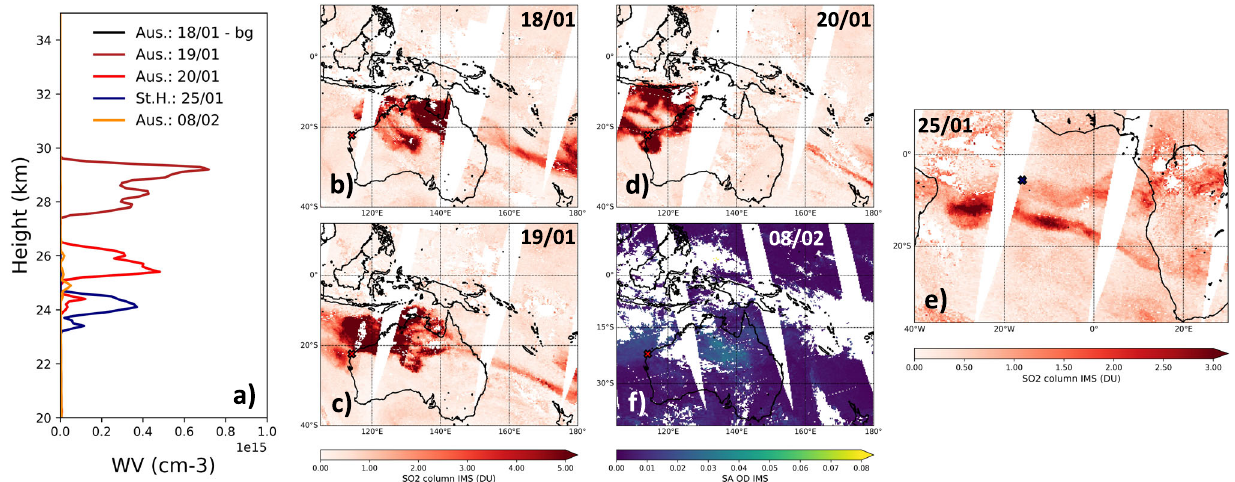
Fig. 4 Water vapour in the HT plume. Water vapour radio-sounding observations over western Australia on 18th January (unperturbed background in RF estimations, black line), 19th (dark red line), 20th (red line), and 8th February (yellow line), and over Saint Helena island (blue line) ( a ). Plume and sounding positions (red crosses) are shown in b – f , using IMS/IASI SO 2 and sulfate-speci fi c AOD observations.